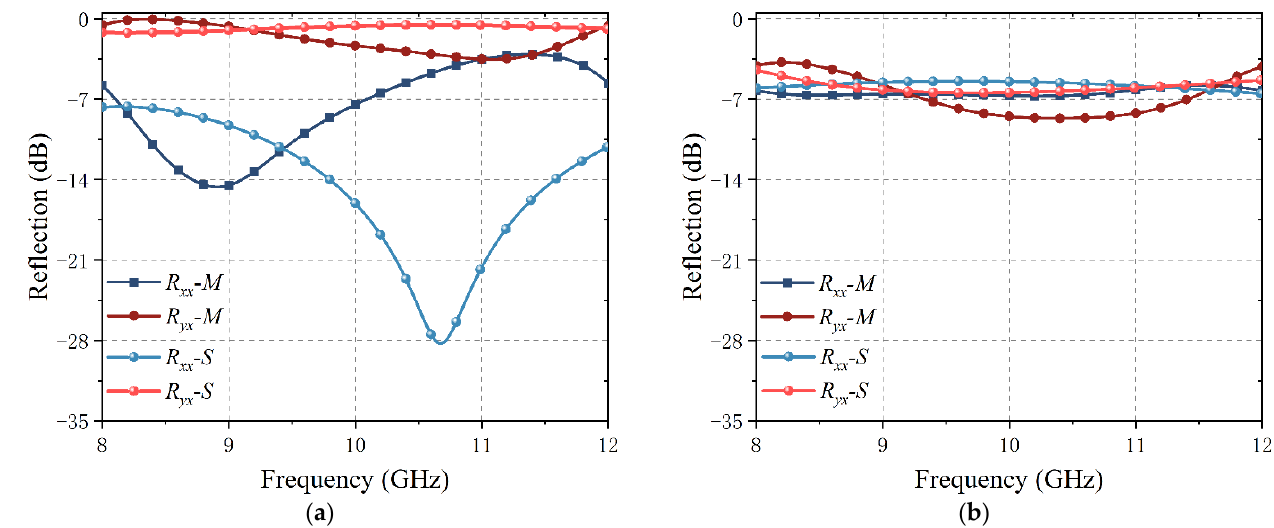
Figure 9. Measured and simulated reflection coefficients R xx and R yx when ( a ) diodes are off, 9 V; ( b ) when diodes are on, 13.4 V.